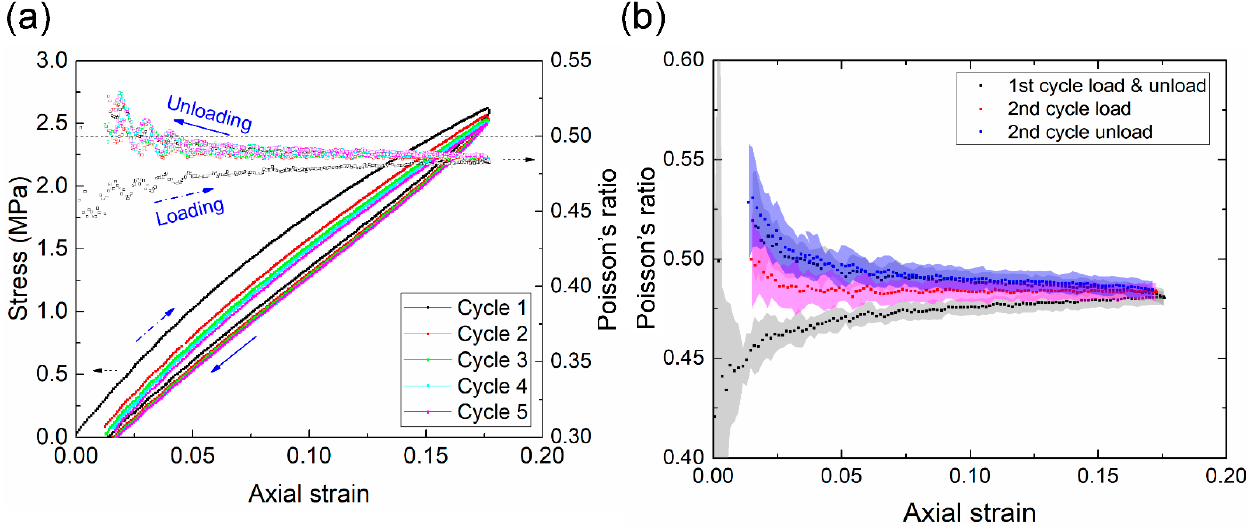
Figure 7. ( a ) The variations of the stress-strain curves and Poisson’s ratio in the cyclic test. ( b ) Means and standard deviations (shaded area) of the Poisson’s ratio (by Hencky strain) at the first and second cycles. The results are based on six samples at a loading rate of 10 mm/min.